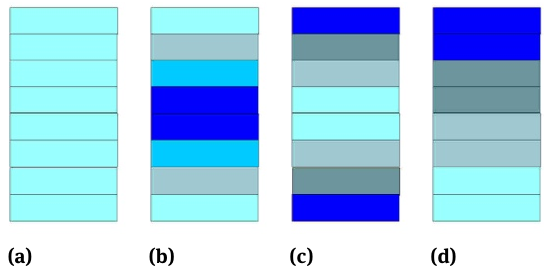
Figure 2: Variants of the wall constructions for plates